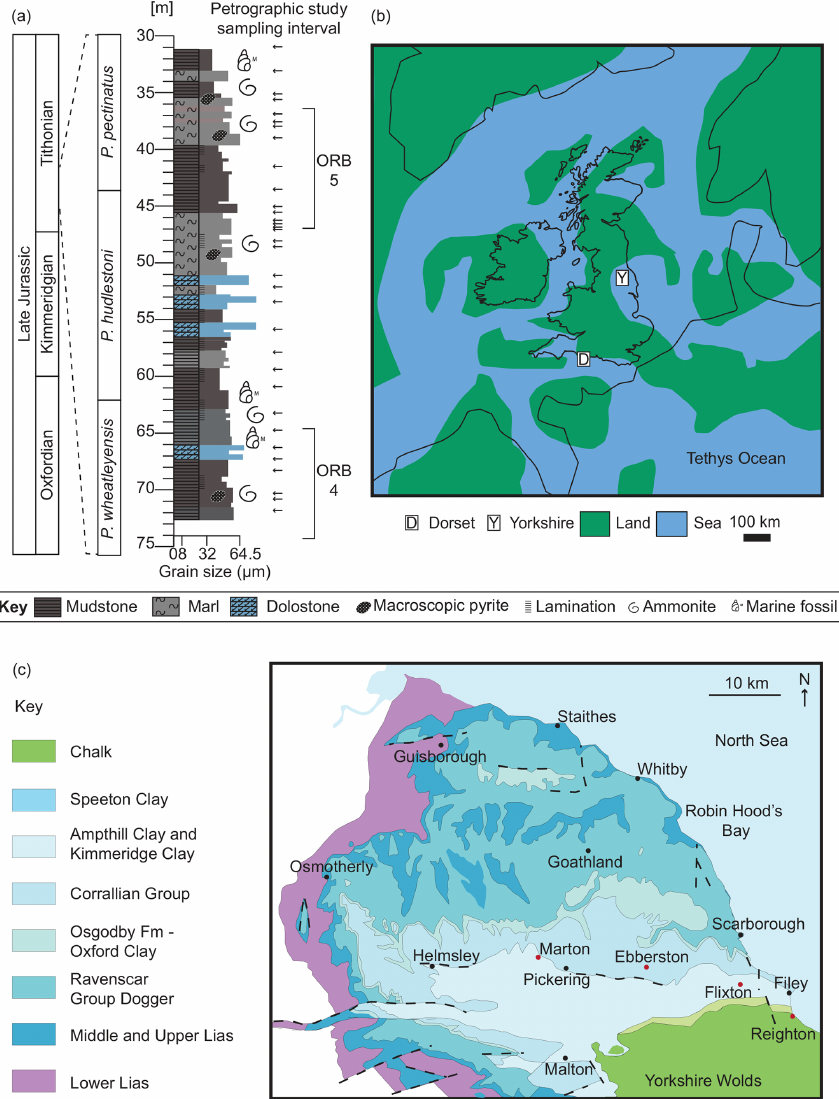
Figure 1. (a) Graphic log showing lithological variation of the studied section against geological time. See key for details. Horizontal arrows point to the petrographic study sample positions. Organic-rich bands (ORBs) 4 and 5 as defined by Gallois (1979). Astrochronology after Huang et al. (2010) and Armstrong et al. (2016). (b) Palaeogeographical map (modified from Turner et al., 2019). (c) Modern-day geological map of the Cleveland Basin (after Powell, 2010). Red dots mark the location of the Marton 87, Ebberston 87, Flixton 87, and Reighton 87